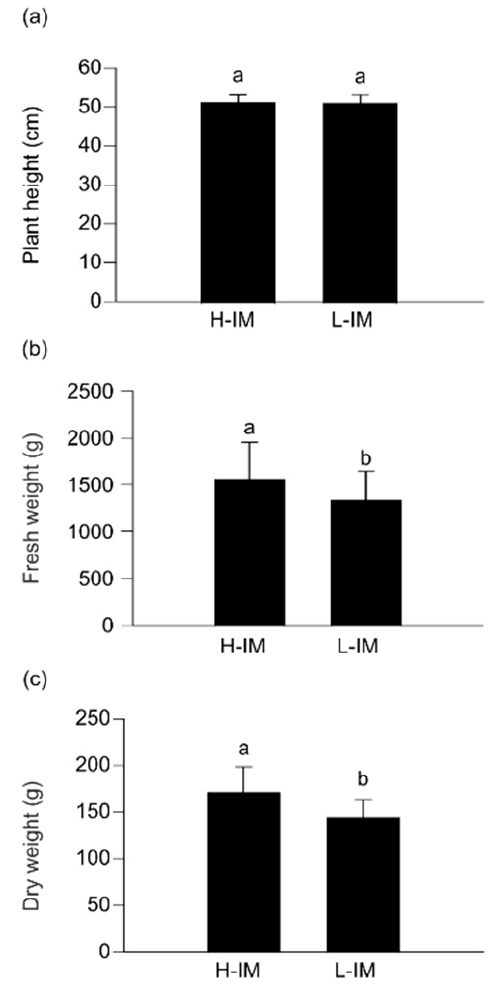
Figure 1. Agronomic parameters in two populations of kale from divergently selected populations with varied indol-3-ylmethylGSL (IM) content (H-IM: High IM content; L-IM: Low IM content). ( a ) Means of plant height of kale populations in all locations. ( b ) Means of fresh weight of 25 leaves of kale populations in all locations. ( c ) Means of dry weight of 25 leaves of kale populations in all locations. Error bars represent ± standard deviation (SD). Within each panel, different letters indicate significant differences between populations (ANOVA, p -value ≤ 0.05). Complete ANOVA table results is presented as Supplementary Material (Table S1).